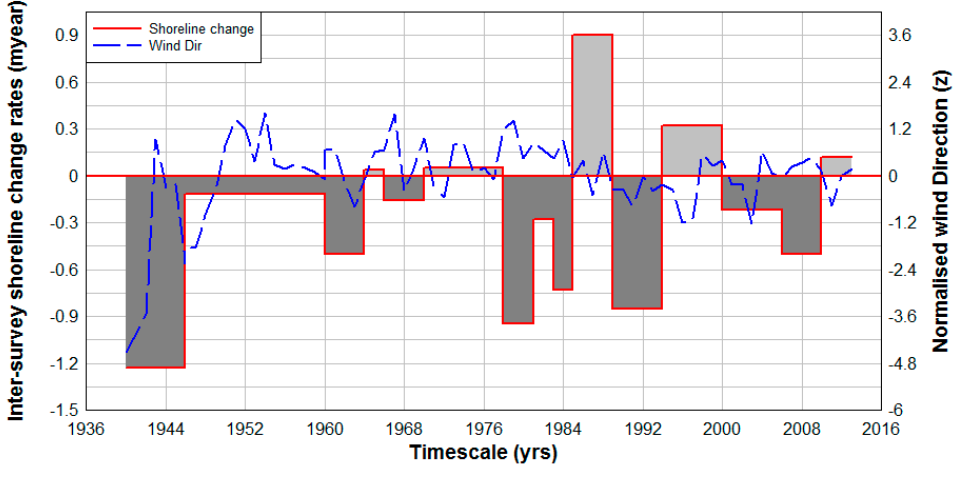
Figure 11. Cont. Figure 11.